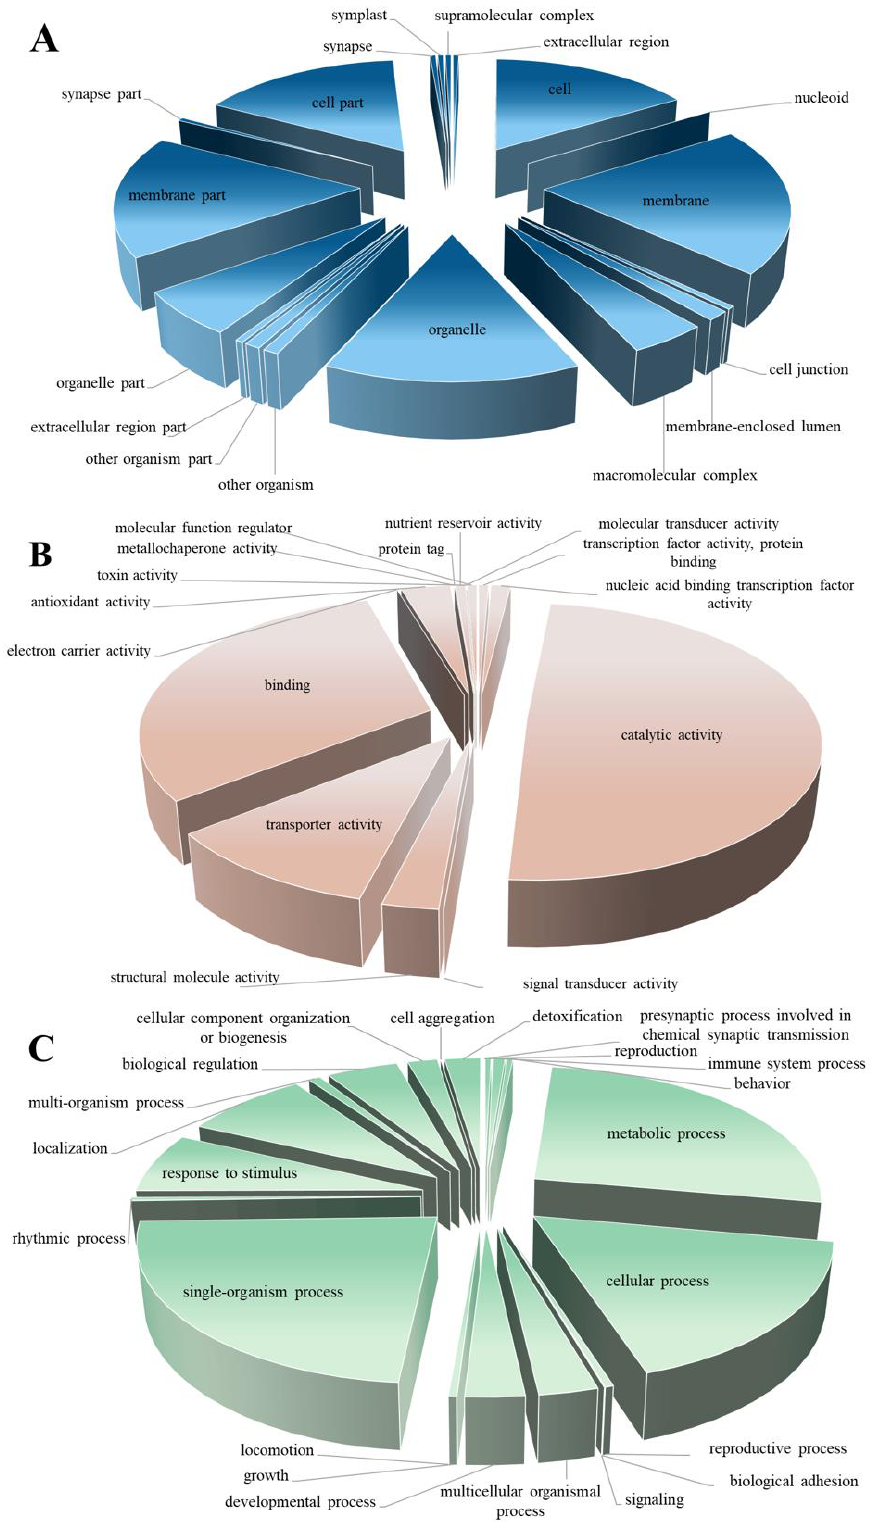
Figure 5. GO term annotation of the DEGs in the CgWT12h transcriptome. The DEGs in the CgWT12h sample were assigned GO terms from the following three main categories: cellular component ( A ), molecular function ( B ), and biological process ( C ).